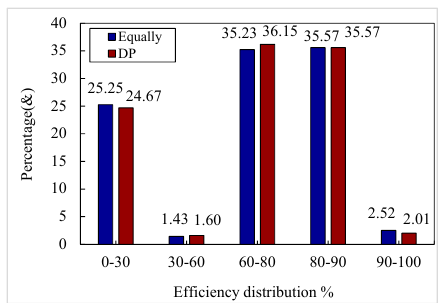
Figure 11. Comparison of motor efficiency distribution of different torque distribution strategies for CUPDC.